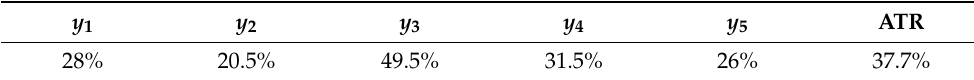
Table 3. RLS: Triggering rates for nodes under condition (9). y 1 y 2 y 3